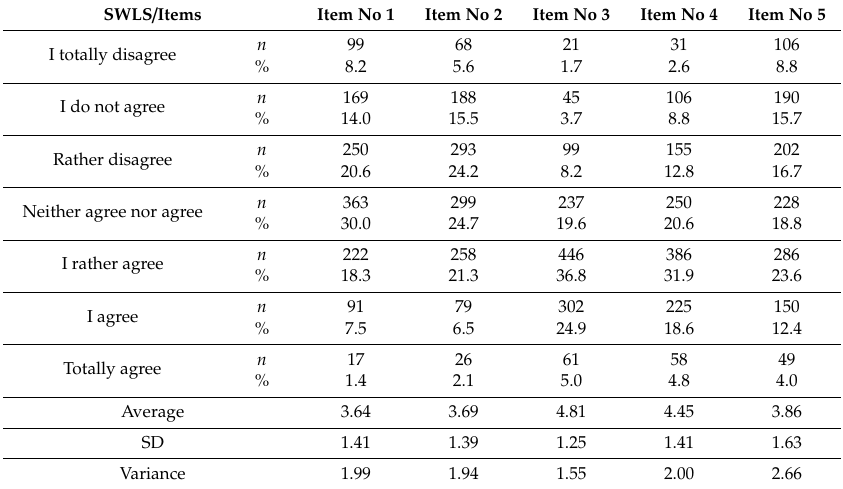
Table 2. Level of life satisfaction in relation to individual items of the scale.